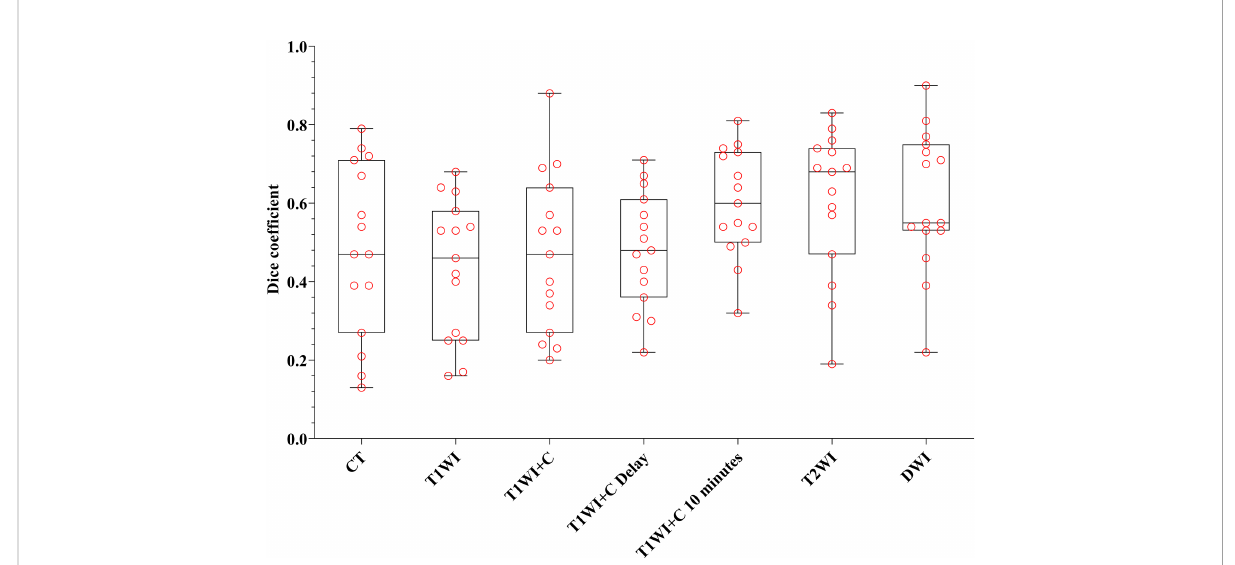
FIGURE 4 The boxplot of DC. The black line of the box is the median, and the length of the box represents the interquartile